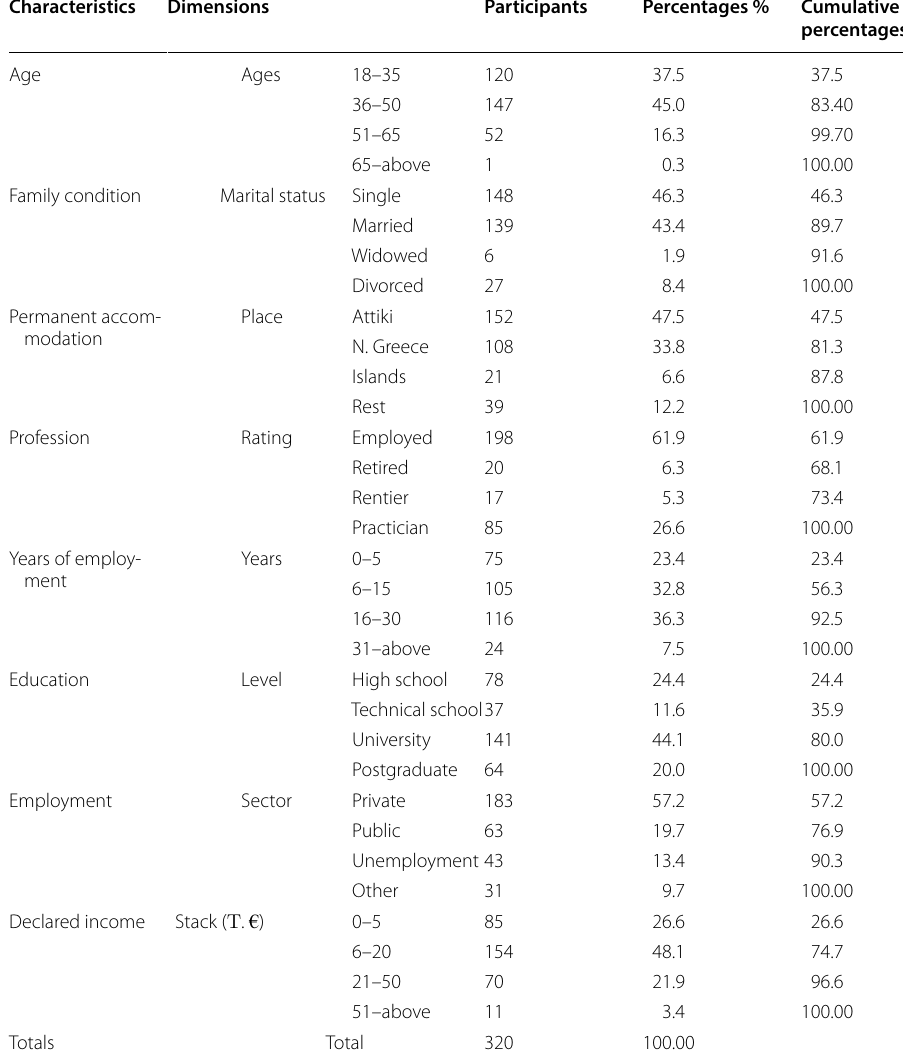
Table 1 Individual characteristics of participants